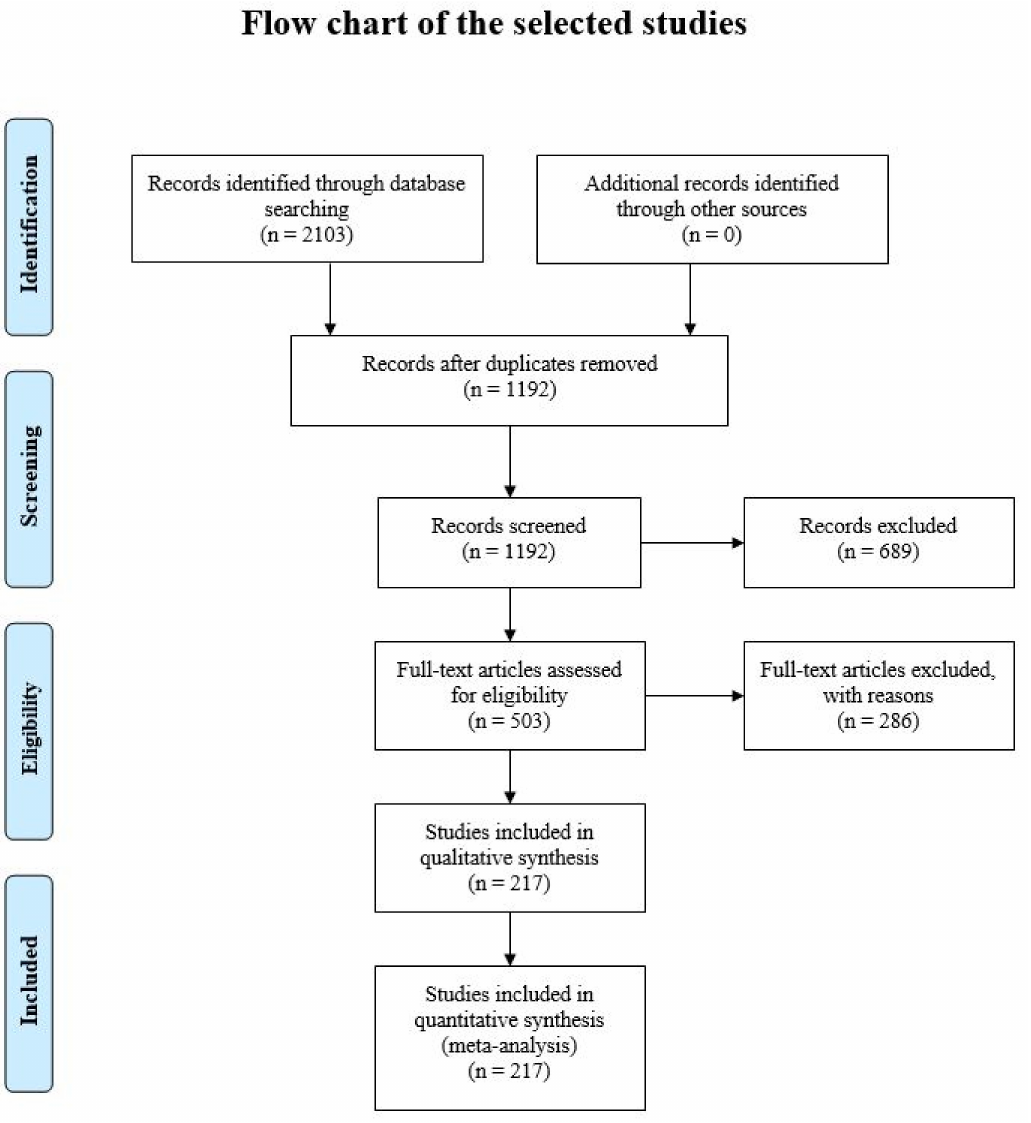
Figure 2. Flow chart of the selection of studies for inclusion in this